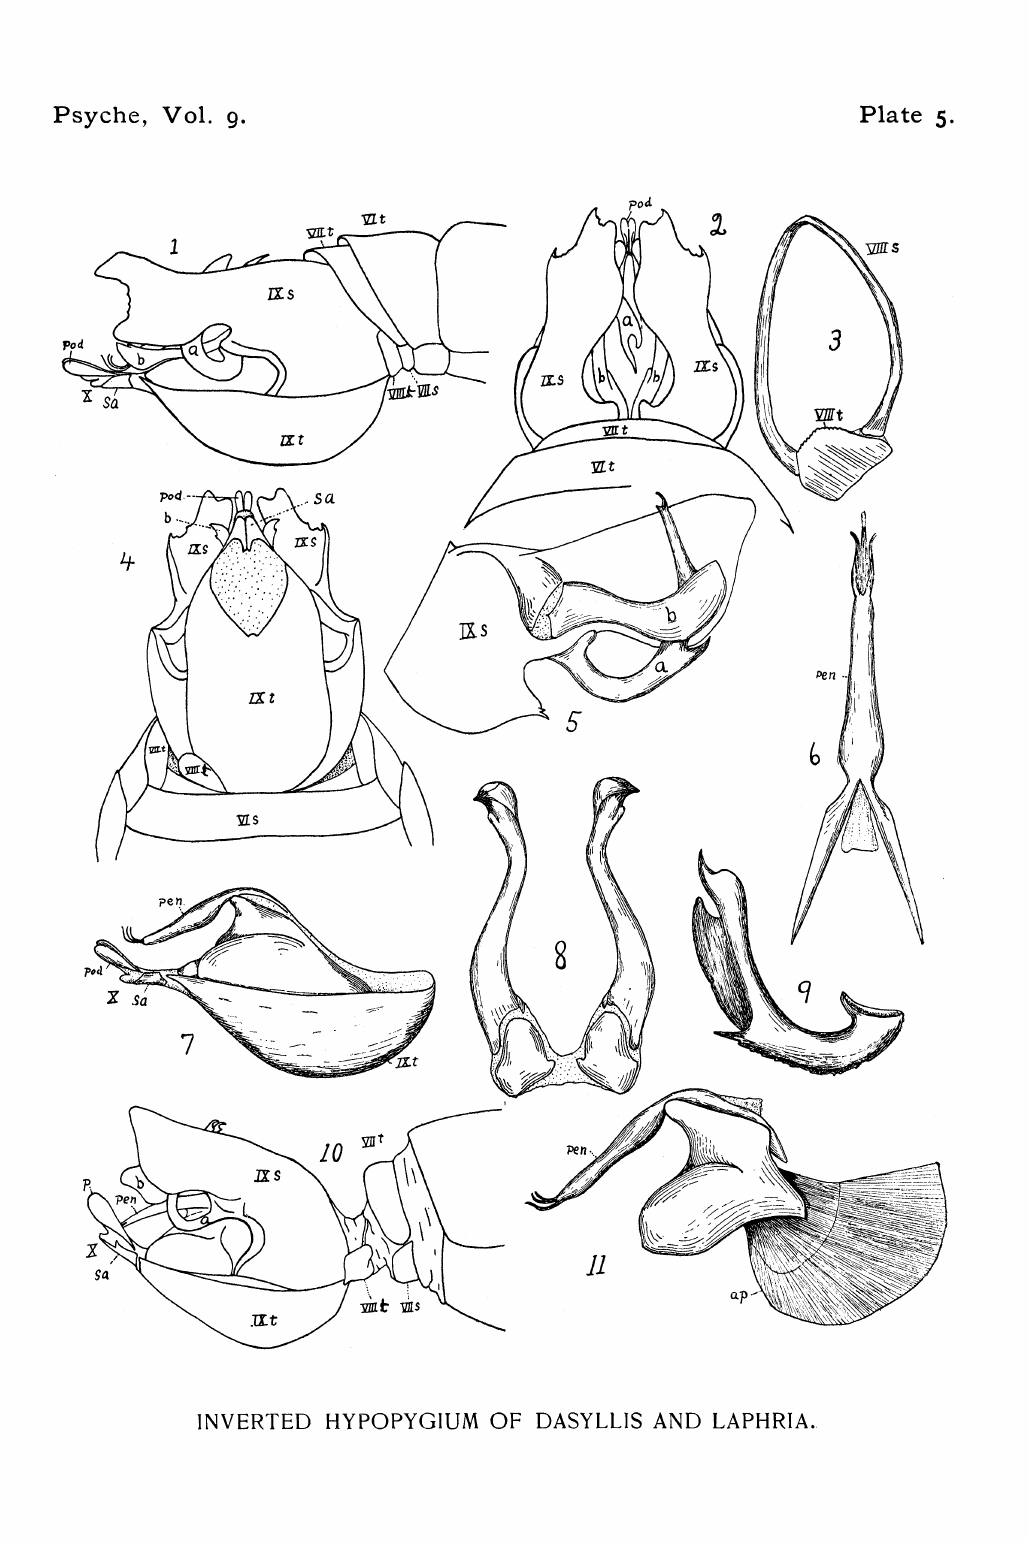
INVERTED HYPOPYGIUM OF DASYLLIS AND